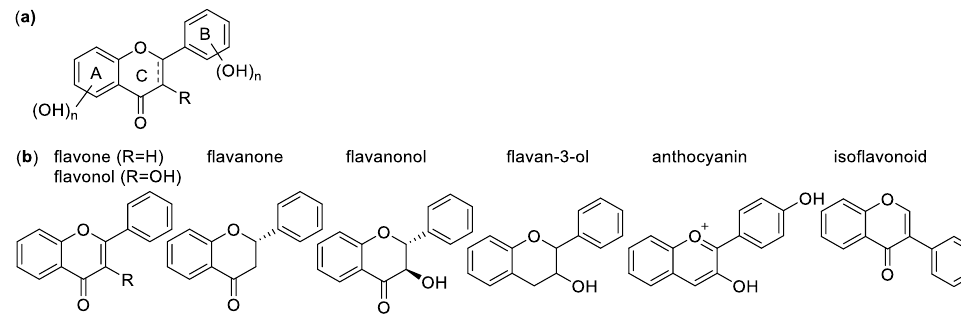
Figure 10. The generic structure ( a ) and major classes of flavonoids( b ).